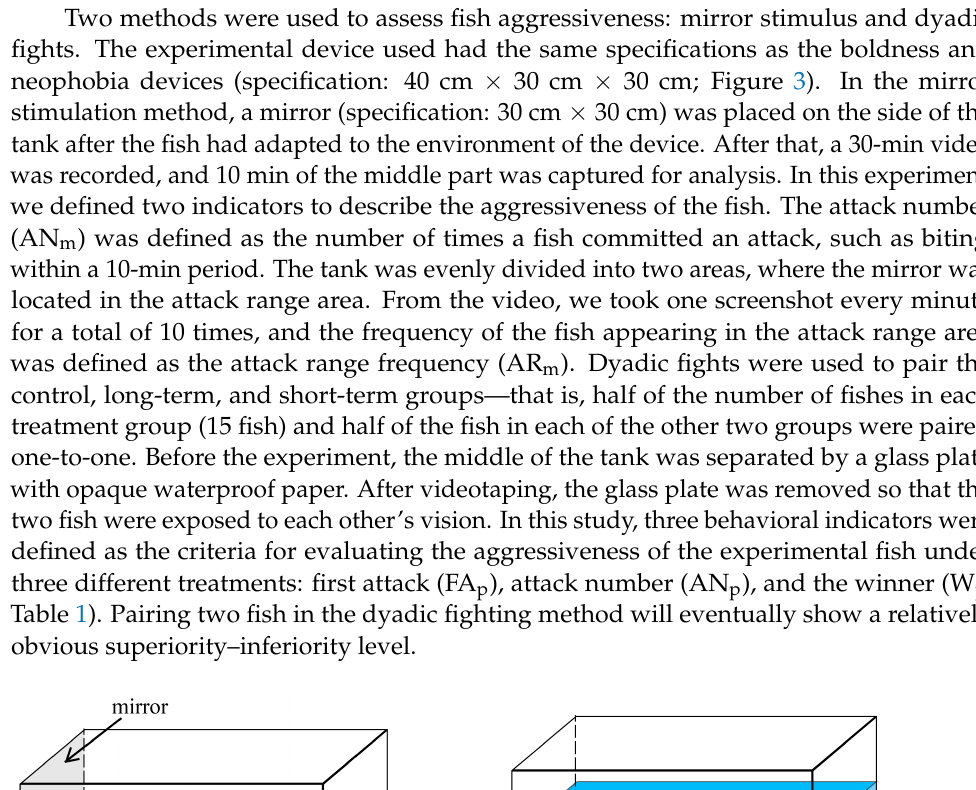
Figure 2. Device used to assess the neophobia of black rockfish ( Sebastes schlegelii Hilgendorf, 1880). The middle of the device was separated by white opaque waterproof paper. The experimental fish were placed on one side, while novelty items were placed on the other. The glass plate was removed at the beginning of the experiment.